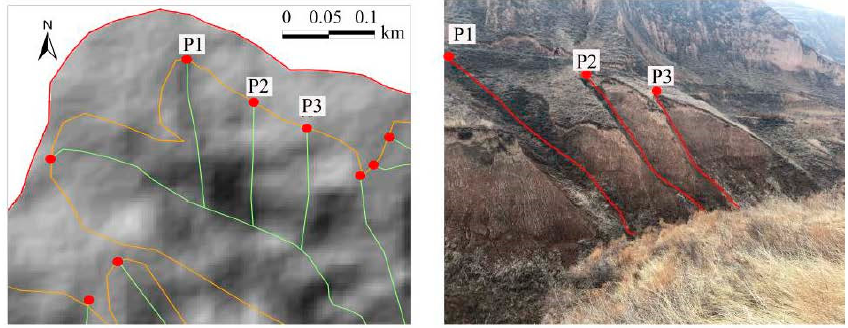
Figure 11. Comparison between the extraction result and field survey.